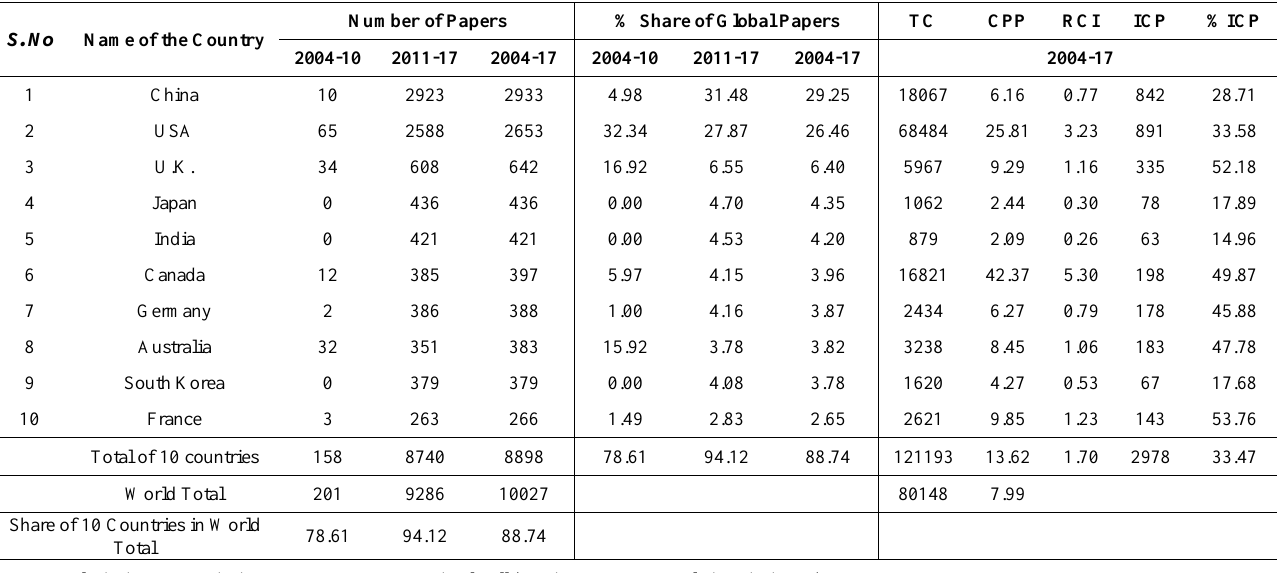
Table 2. Global research output, publication share, international collaborative publications and citation impact of top